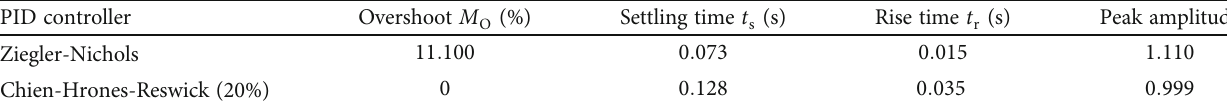
Figure 22: Vehicle acceleration (a) and speed (b) responses, respectively, in PID-CC (3). Table 5: Transient response to a single-step